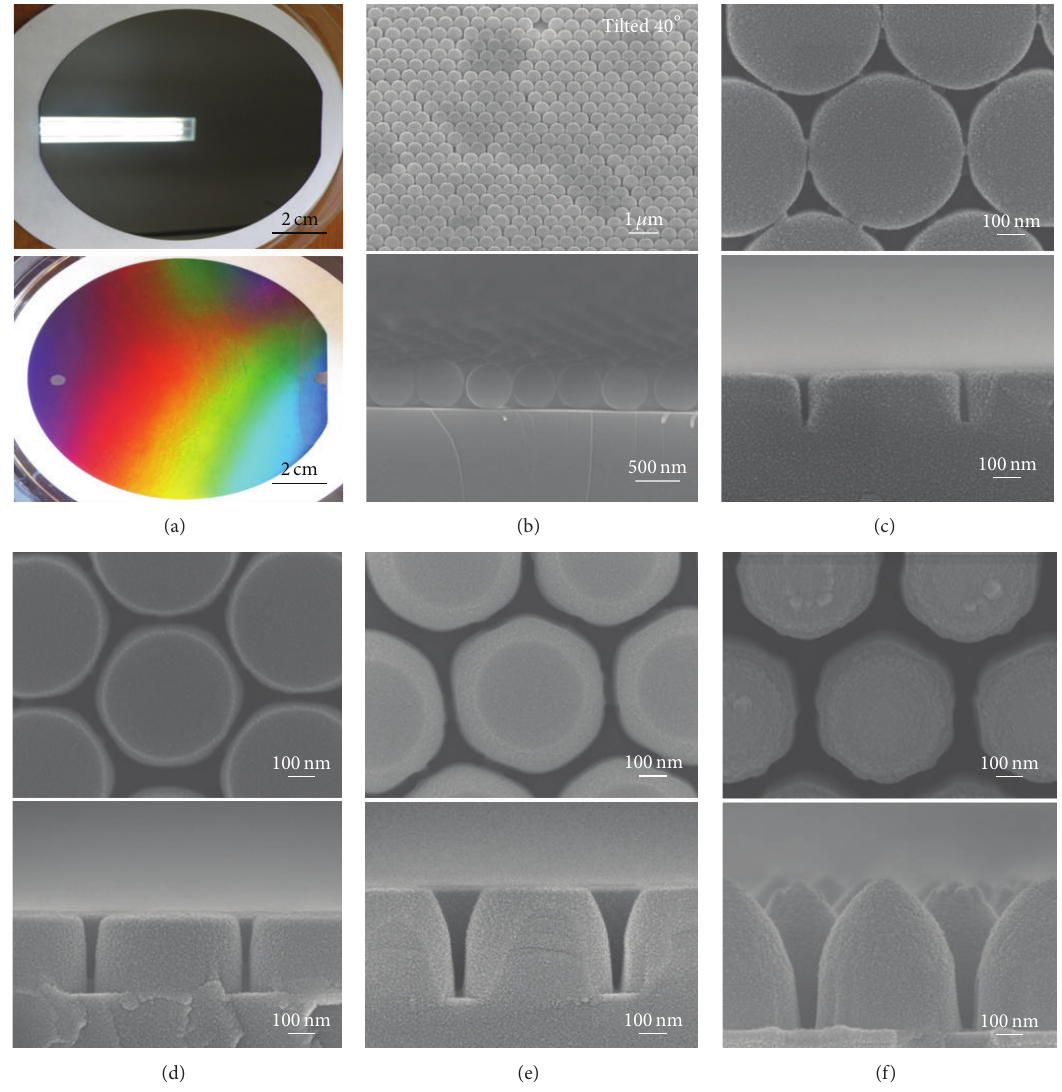
Figure 3: (a) Photograph of 4 󸀠󸀠 bulk silicon wafer (top) and a monolayer array of 550 nm nanospheres that were deposited on a 4 inch silicon wafer (bottom). (b) Close view of a monolayer nanosphere on Si wafer; ((c)–(f)) NPSiS with different dry etching times: (c) NPSiS-1, 80s (depth: 180 nm), (d) NPSiS-2, 150 s (depth: 270 nm), (e) NPSiS-3, 230 s (depth: 370 nm), and (f) NPSiS-4, 450 s (depth: 550 nm).